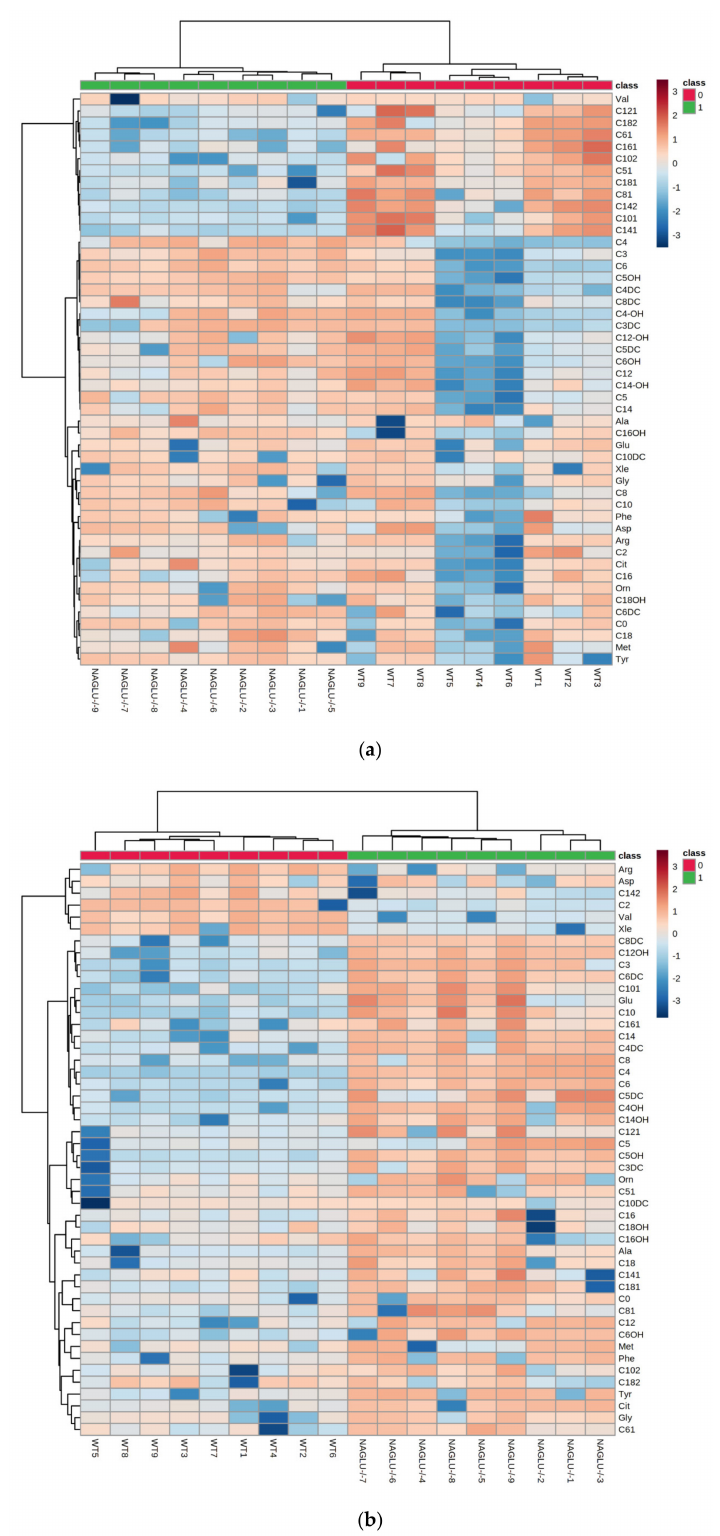
Figure 3. Hierarchical cluster analysis and heatmap of the metabolites in the ( a ) heart and ( b ) liver tissues from NAGLU − / − and WT mice. The concentrations of the metabolites from NAGLU − / − and WT heart and liver were normalized according to protein tissue contents, log(2) transformed, and Pareto scaled. The color code in the heatmap represents the relative metabolite abundance: red and blue colors mean increased and decreased levels of each metabolite in NAGLU − / − versus WT,